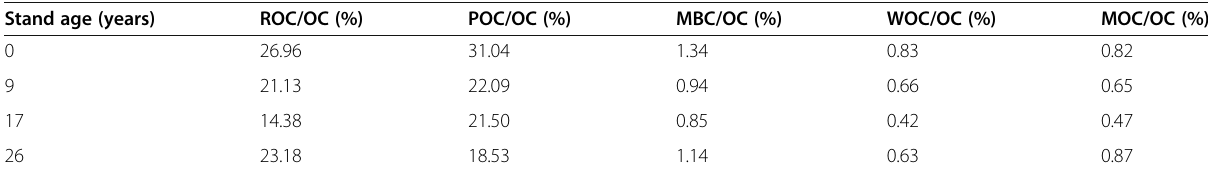
Table 9 The proportions of labile organic carbon fractions (ROC, POC, MBC, WOC, and MOC) accounting for organic carbon in the Chinese fir plantations with different stand ages (0, 9, 17, and 26 years old) Stand age